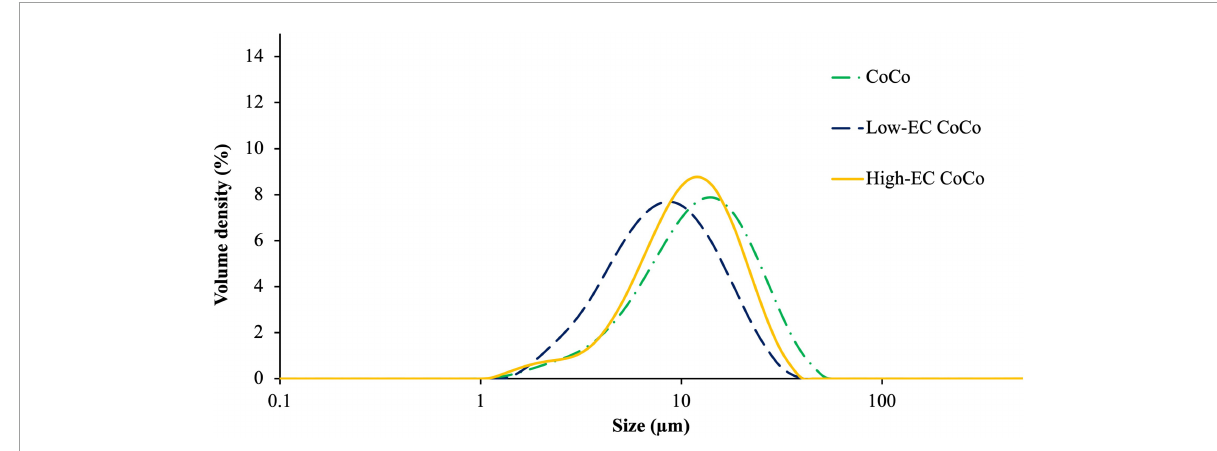
FIGURE7 The size distribution of limonene-loaded CoCo, low-EC CoCo, and high-EC CoCo powders.